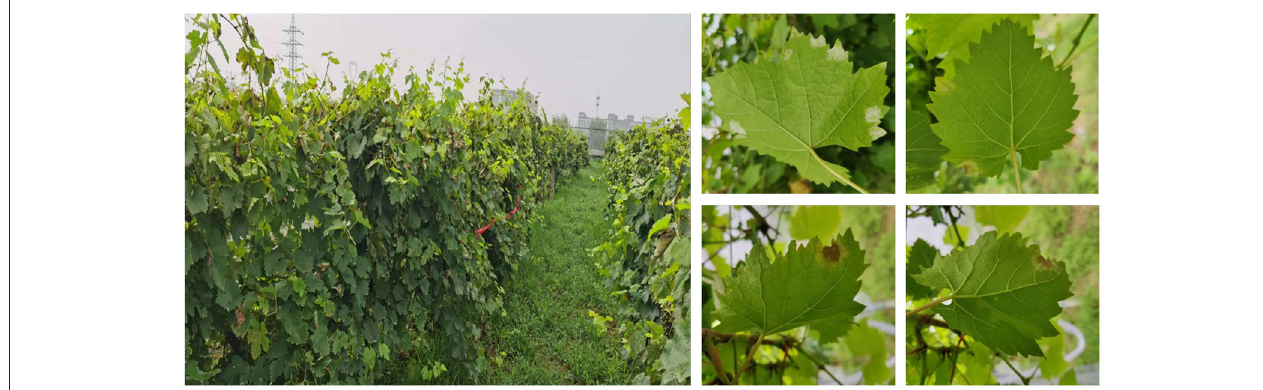
FIGURE 1 | Commercial vineyard and acquired images under natural light conditions.